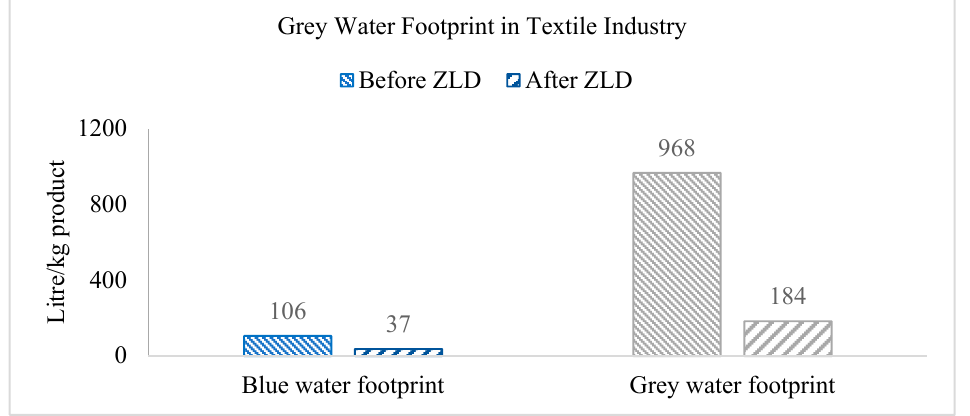
Figure 16. Water footprint for per kg fabric before and after